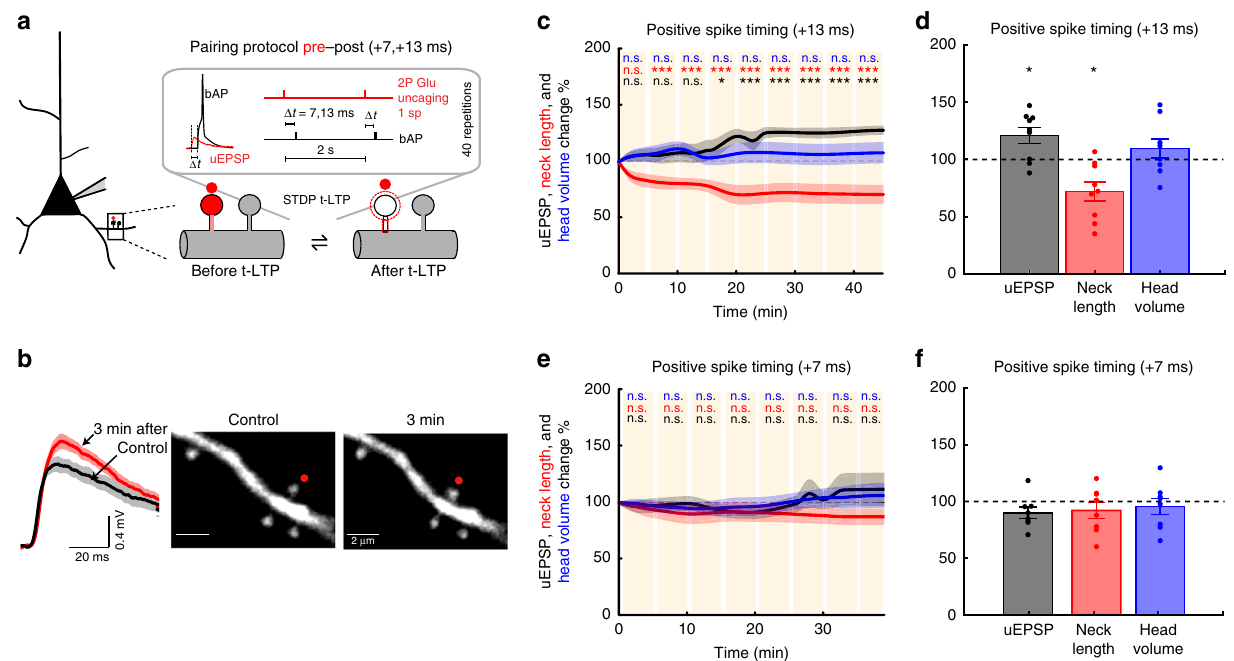
Fig. 1 Induction of t-LTP in single dendritic spines. a Experimental protocol for t-LTP induction in single dendritic spines (sp). b Representative experiment where a spine was activated with t-LTP pre – post pairing protocol of + 13 ms. Traces correspond to average of ten uEPSPs recorded in the soma and generated by 2P uncaging before (control, black trace) and after t-LTP induction (red trace) over the indicated spine (red dot). c Time course of uEPSP amplitude, neck length, and spine head volume ( P < 0.001, P < 0.001, and P = 0.25, respectively, n = 9 spines, one-way repeated-measures ANOVA) following STDP induction with pre – post timing of + 13 ms. n.s. not signi fi cant; * P < 0.05; *** P < 0.001, post hoc Dunnet ’ s test. d Changes in uEPSP amplitude, neck length, and head volume of the activated spine 15 – 25 min after t-LTP induction with a pre – post timing of + 13 ms (uEPSP = 121.00 ± 6.98%, P = 0.039, neck length = 71.88 ± 8.29%, P = 0.019, spine head volume = 109.63 ± 8.84%, P = 0.38; n = 9 spines, two-sided Wilcoxon test; * P < 0.05). e Time course of uEPSP amplitude, neck length, and spine head volume ( P = 0.45, 0.09, and 0.36 respectively, n = 8 spines, one-way repeated-measures ANOVA) changes following STDP induction with pre – post timing of + 7 ms. n.s. not signi fi cant, post hoc Dunnet ’ s test. f Changes in uEPSP amplitude, neck length, and head volume of the activated spine 15 – 25 min after t-LTP induction with a pre – post timing of + 7 ms (uEPSP = 90.06 ± 5.00%, P = 0.15; neck length = 92.10 ± 7.15%, P = 0.38; spine head volume = 95.67 ± 7.25%, P = 0.84; n = 8 spines, two-sided Wilcoxon test). Shaded area and error bars represent SEM and Time 0 represents the end of the STDP induction protocol. Lines, bars, and dots in c – f : uEPSP = black, neck length = red, and head volume =